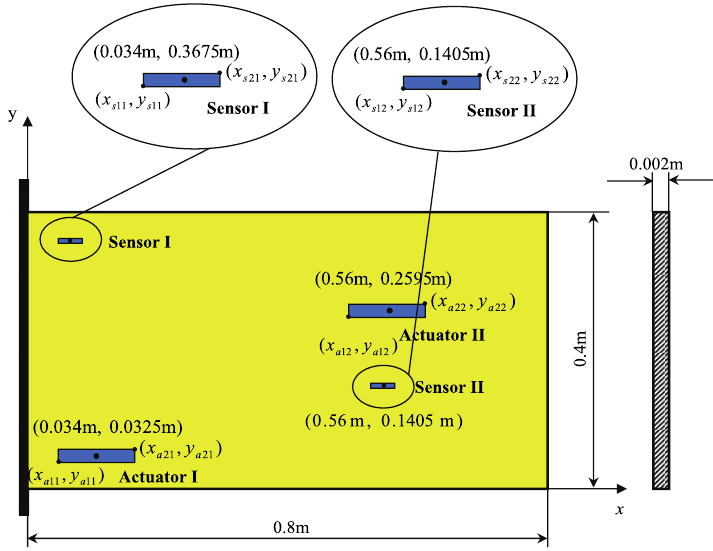
Fig. 1. Structural model of flexible